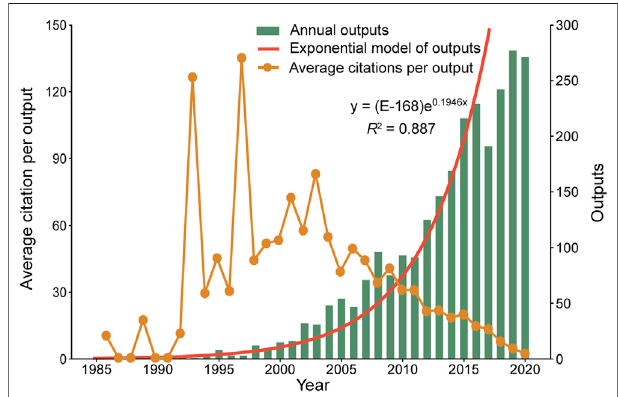
FIGURE 3 | Annual outputs and average citations per output of the research on deserts in China from 1986 to 2020 in the SCI-E database. The red line is the predicted exponential model of annual outputs.